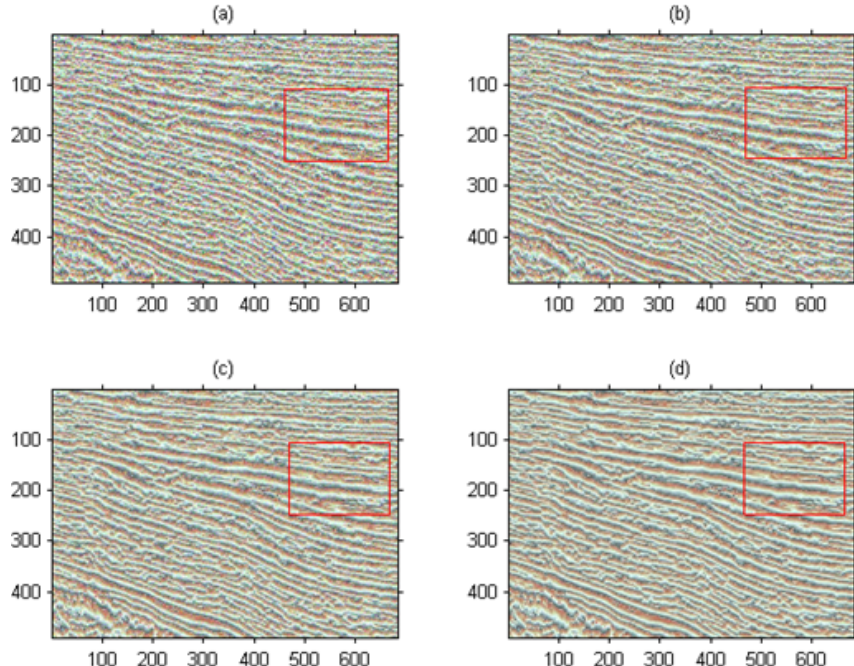
Figure 6. Comparison of algorithm results. The red box shows the contrast enhancement of local texture feature of seismic section image.